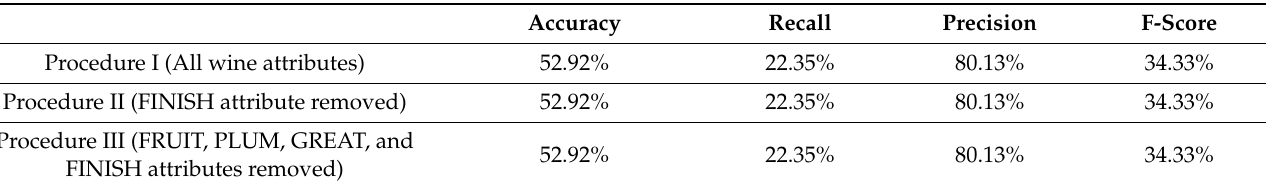
Table 5. Results of the performance of the naïve Bayes algorithm on the wine dataset.